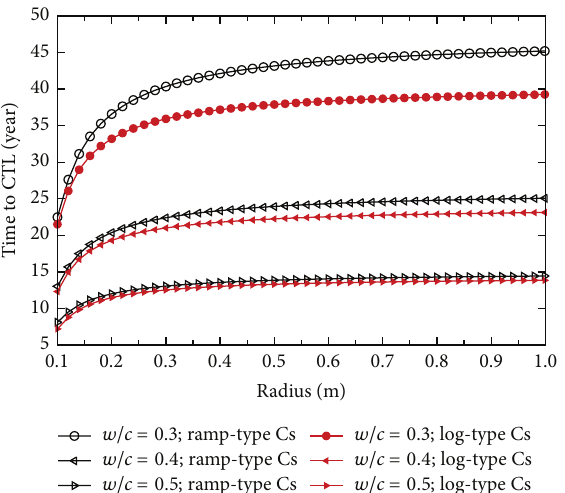
Figure 1: The sensitivity of chloride concentration with respect to spatial step ( ℎ ) for two temporal steps ( 𝜏 = 1 and 10 days). Concentrations were sampled at 𝑟 = 0 . 3m of a concrete column of radius 0 . 4 m, after 20 years of exposure to chloride environments [6]. 𝑤/𝑐 = 0 . 5.